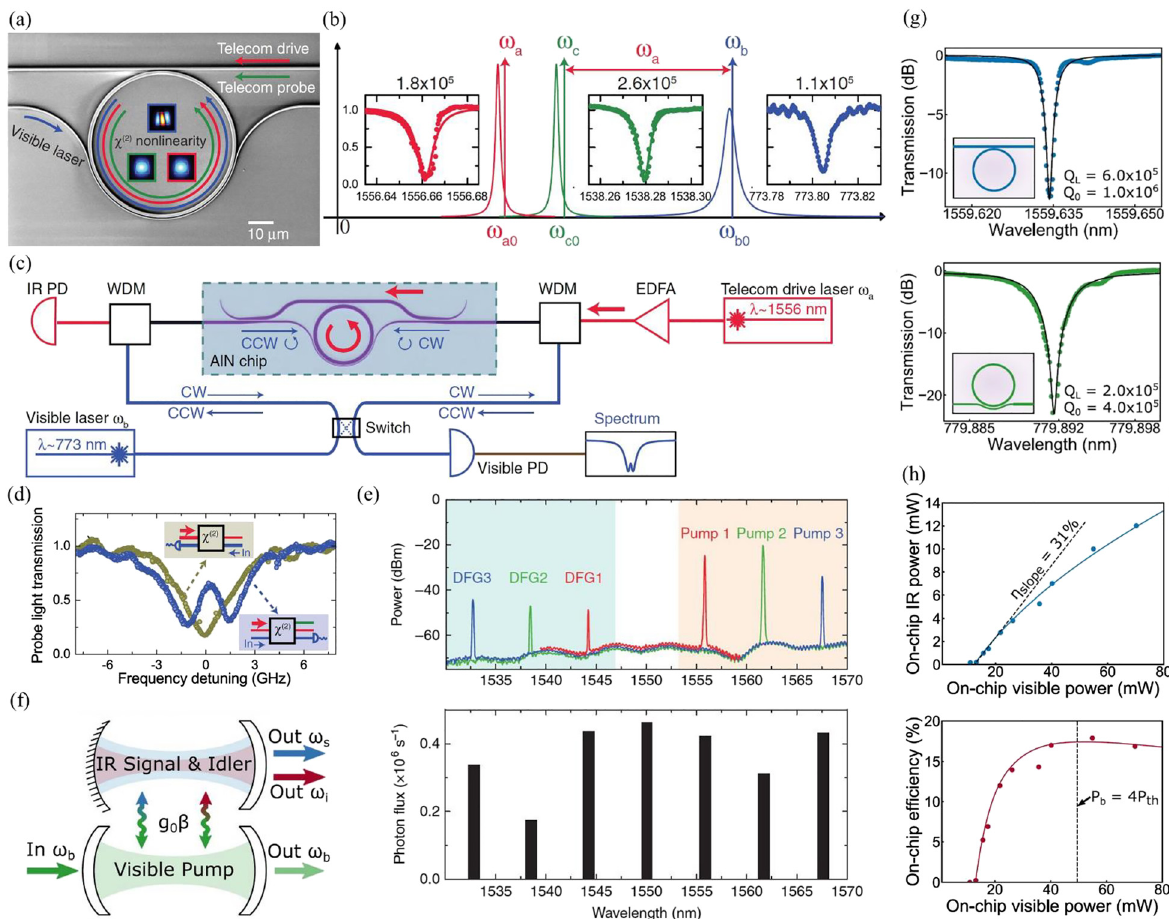
Figure 11: AlN-based integrated devices for three wave mixing (TWM), parametric down conversion, and optical parametric oscillator (OPO). (a)SEMimageofAlNmicroringresonator(withouttopcladding)forTWM.(b)Schematicofopticalresonancemodeswithtransmissionspectra. Loaded Q ofeachmodeismarkedattop.(c)TWMexperimentalsetup:telecomdrivesignalat1556nm( ω a )cascadedwithEDFAto excitecavity mode in CCW direction. A visible laser at 773 nm ( ω b ) probes the mode in either CW or CCW direction, through a switch. Spectrum analyzer is placedaftervisiblephotodetector(PD).(d)Capturedspectrumof visiblemodeinCWandCCWdirection.Modesplittingcanbeobservedwhen the visible signalis propagating in CCW,which is thesame directionas telecomdrive laser signal.Insets illustratethe nonreciprocal property of this nonlinear optical process within the cavity. (a) – (d) Adapted with permission from [128], copyright (2016) by the American Physical Society.(e)Top:opticalspectraof DFGunderdifferentIRpumpwavelengths.Bottom:photon fl uxat differentmicroringresonances,including bothnondegenerateanddegeneratedownconversion.Thevariationofphoton fl uxatdifferentmodesiscontributedbythedifferenceincavity Q . The photon counts are calibrated by the wavelength-dependent detection ef fi ciency of PD. (e) is adapted with permission from [98]. Licensed under a Creative Commons Attribution. (f) Schematic showing mechanism of OPO process. It consists two coupled cavities, one for pump ( ω b ) at visible, the other for signal ( ω s ) and idler ( ω i ) at IR, which are coupled through χ (2) nonlinear effect with strength g 0 β . (g) Top and bottom: measured transmission spectra at IR and visible wavelengths, respectively. Loaded Q and intrinsic Q of the cavity for IR and visible wavelength are also included. (h) Power (top panel) and ef fi ciency (bottom panel) with respect to on-chip visible power for degenerate OPO process. A high slope ef fi ciency of 31% has been obtained after linear fi tting of on-chip IR power with respect to on-chip visible power. A maximumOPOef fi ciencyof17%isachievedinbottompanel,whichisclosetohalfofslopeef fi ciencyof31%obtainedintoppanel.Dashedline inbottompanelindicatestheon-chipvisiblepowerformaximumon-chipef fi ciencytheoretically.(f) – (h)Adaptedwithpermissionfrom[129]© The Optical